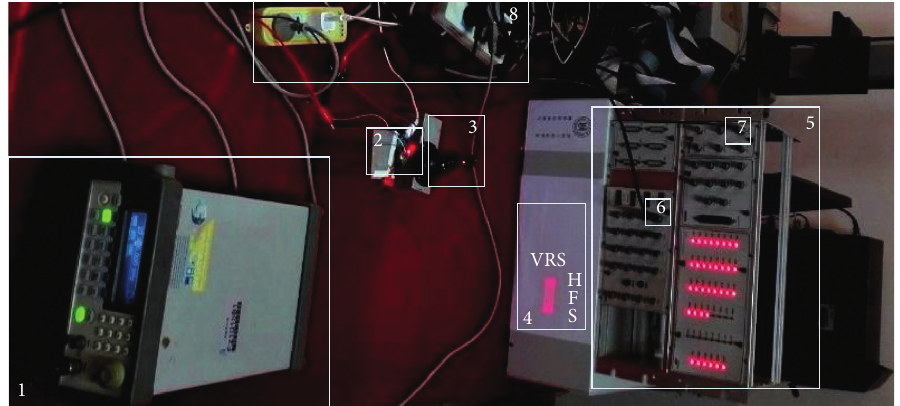
Figure 11: Raster scanning realized by the electromagnetic micromirror of two dimensions: 1. function waveform generator (Agilent 33250A); 2. electromagnetic micromirror with FTPS, driving circuits, and data acquisition circuits; 3. red laser; 4. screen; 5. dSPACE and PC; 6. V 1; 7. V 1; 8. in out